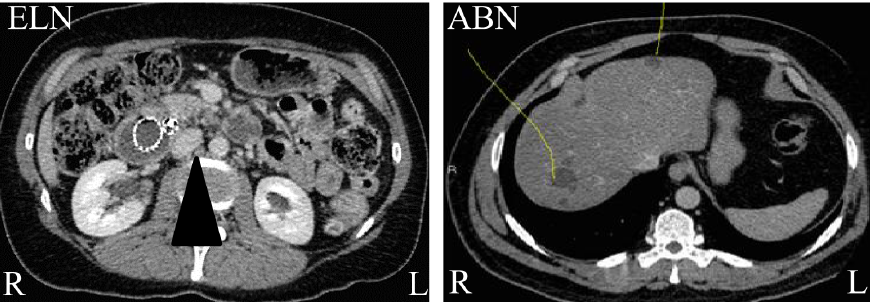
Figure 1. Cross-sectional abdominal CT-images used in the experiment. The CT-images depict an enlarged lymph node from an ELN-video (arrowhead in a) and liver cysts from an ABN-video (yellow lines in b). Note that the left and right side of the body are switched in the